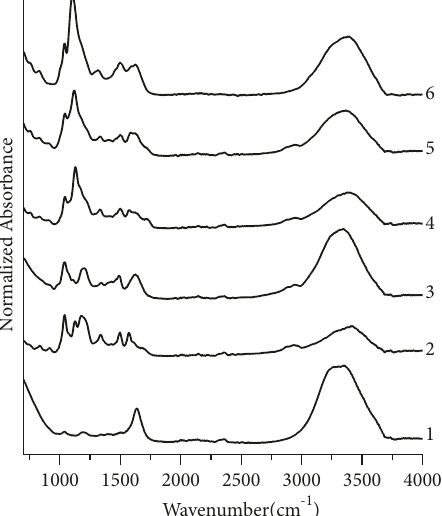
Figure 9: Normalized FTIR absorption spectra for red fountain pen inks. 1 and 2 represent samples no. RD1 and RD2,